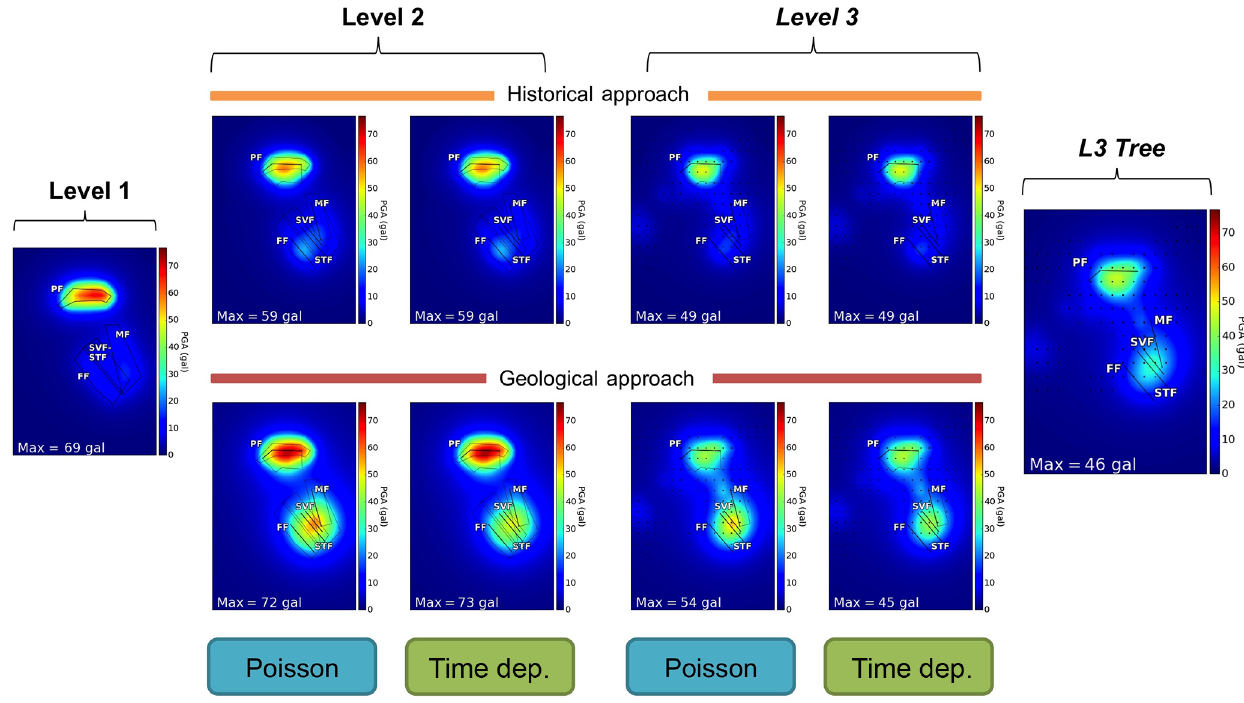
Figure 9. Hazard results for a 10% exceedance probability in 5 years in terms of PGA, when V s30 = 800ms − 1 . Thickest lines indicate fault traces.